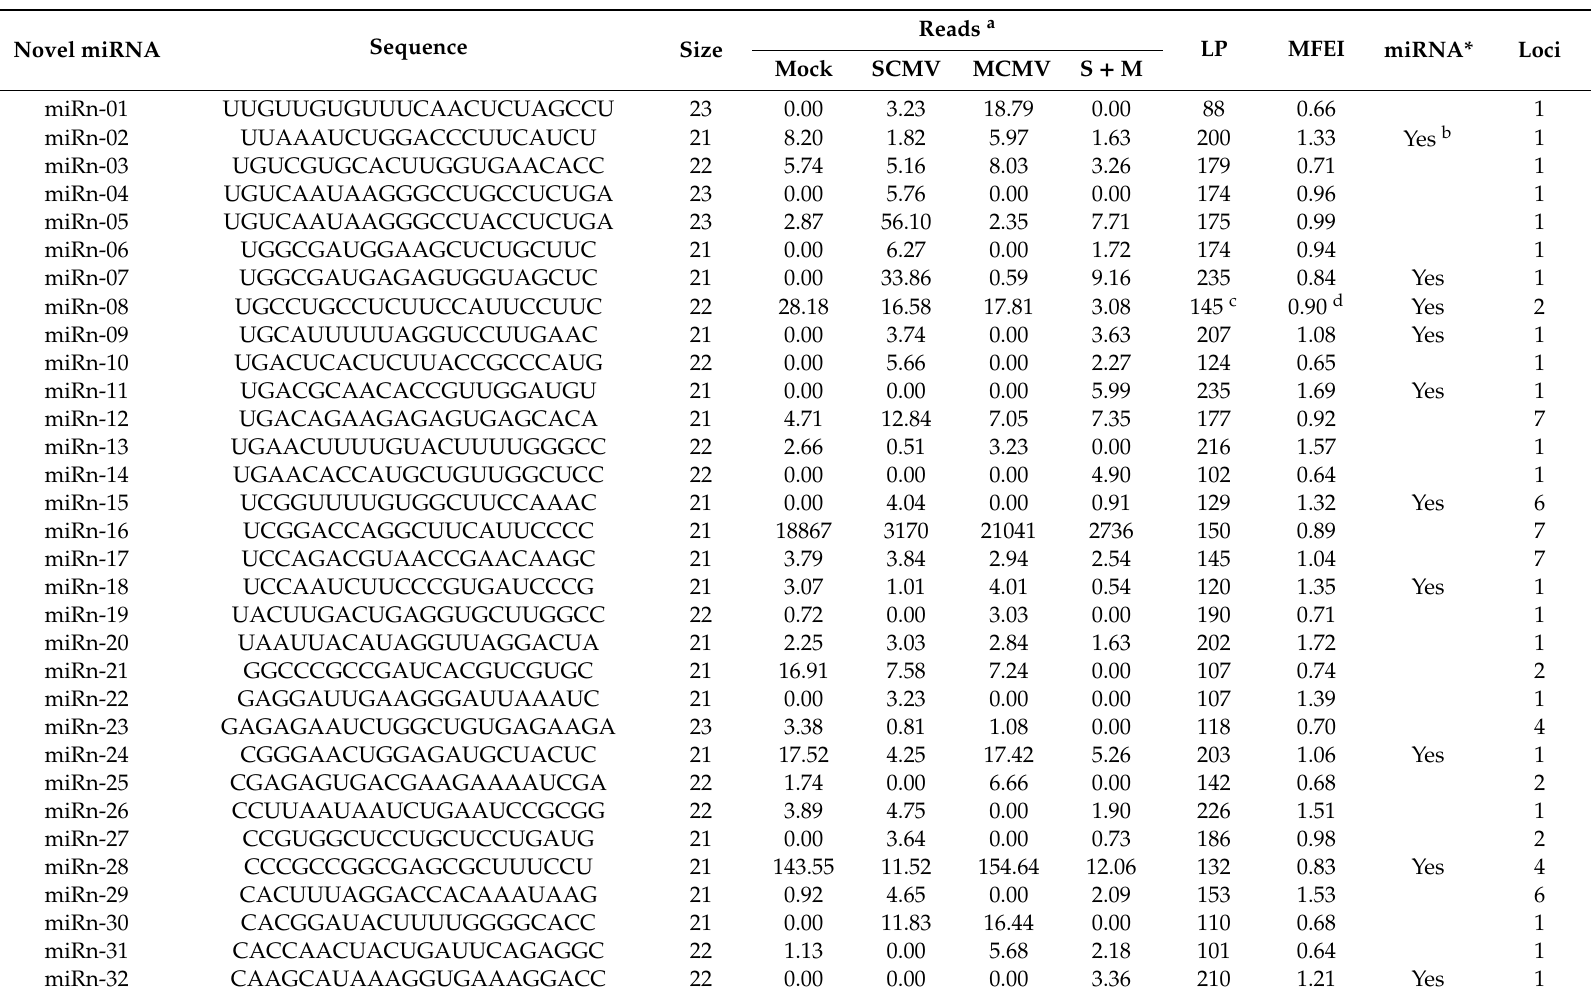
Table 2. The characterization of novel